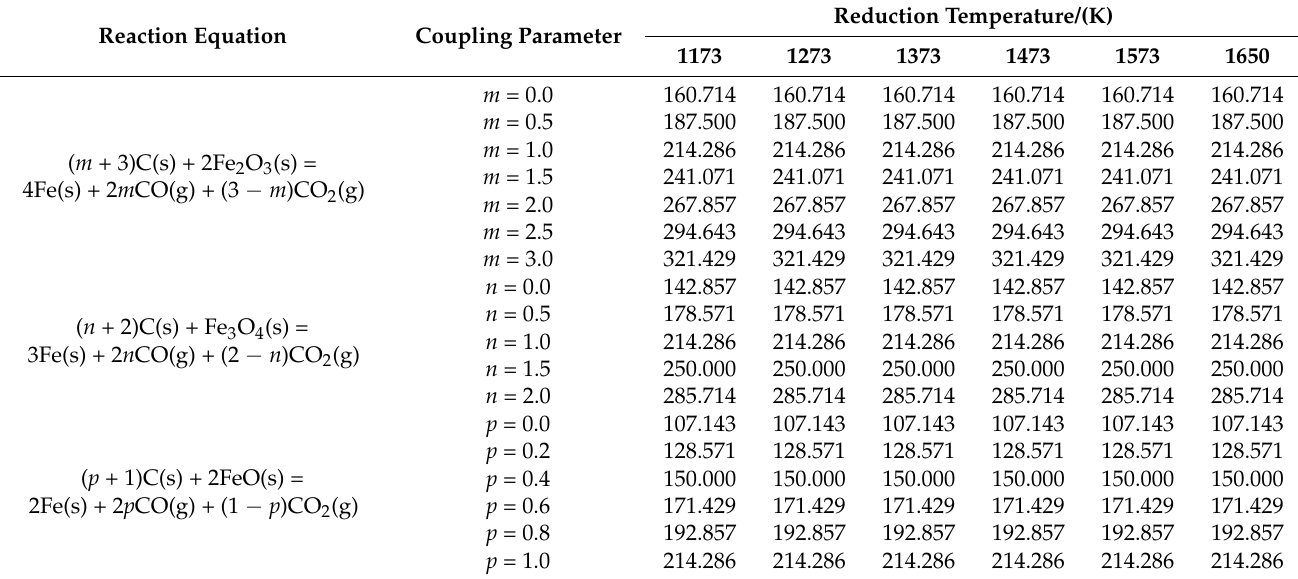
Table 8. The carbon consumption used as reduction agent for coupling reactions per ton of liquid iron (kg C/t). Reaction Equation Coupling Parameter